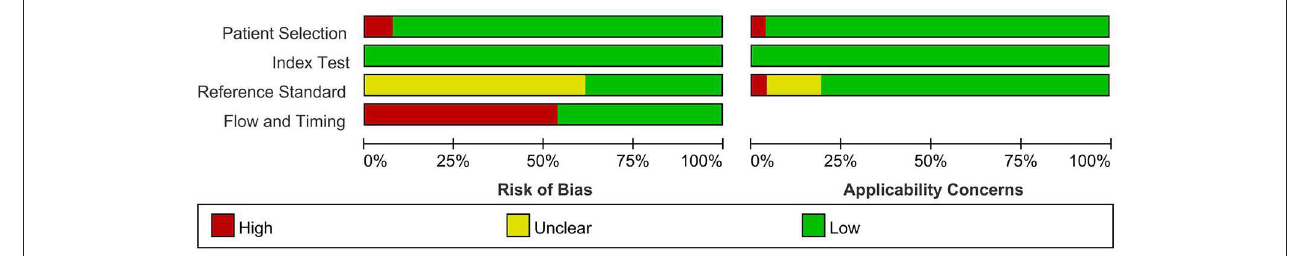
FIGURE 3 | Percentage of the studies with risk of bias and applicability concerns in the different domains of QUADAS-2.